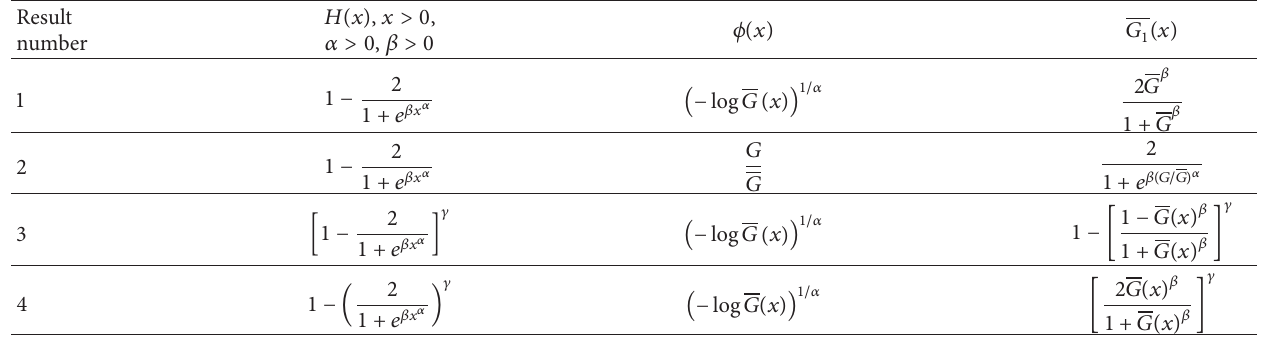
Table 4: Families of distributions generated.